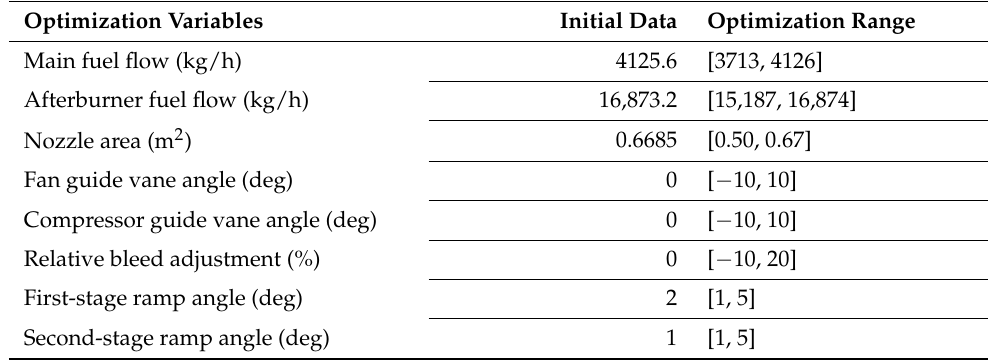
Table 1. Optimization of initial conditions and parameter ranges. Optimization Variables Initial